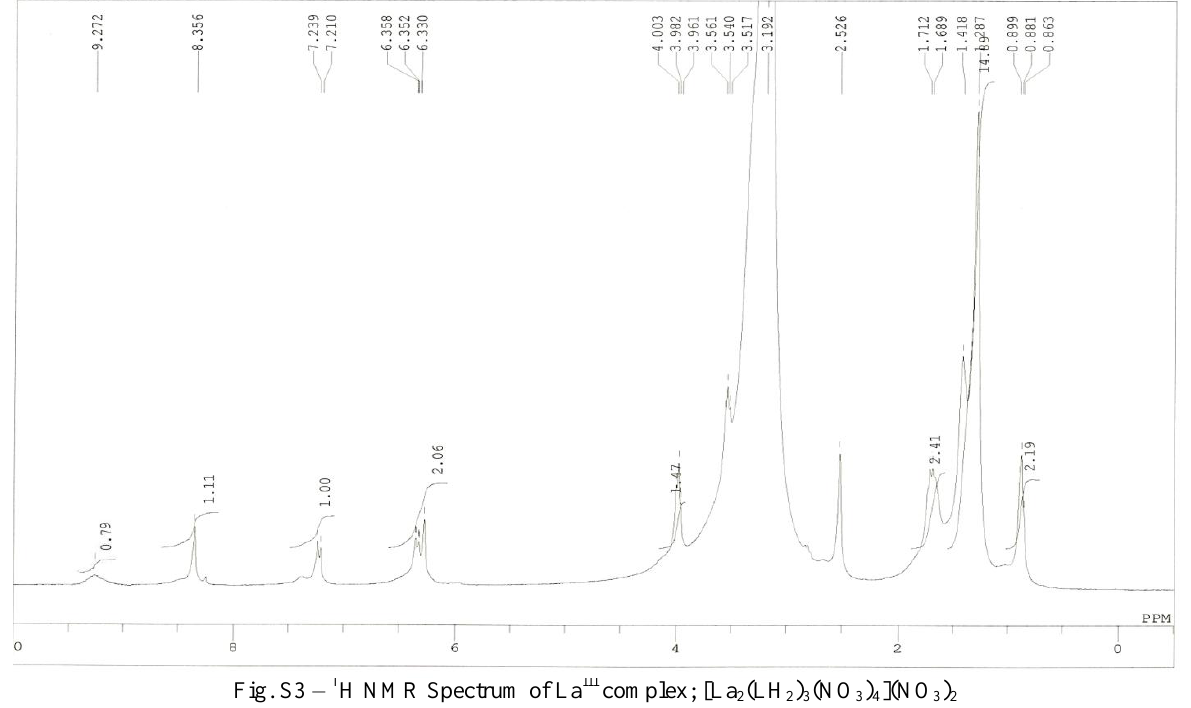
Fig. S3 – 1 H NMR Spectrum of La III complex; [La